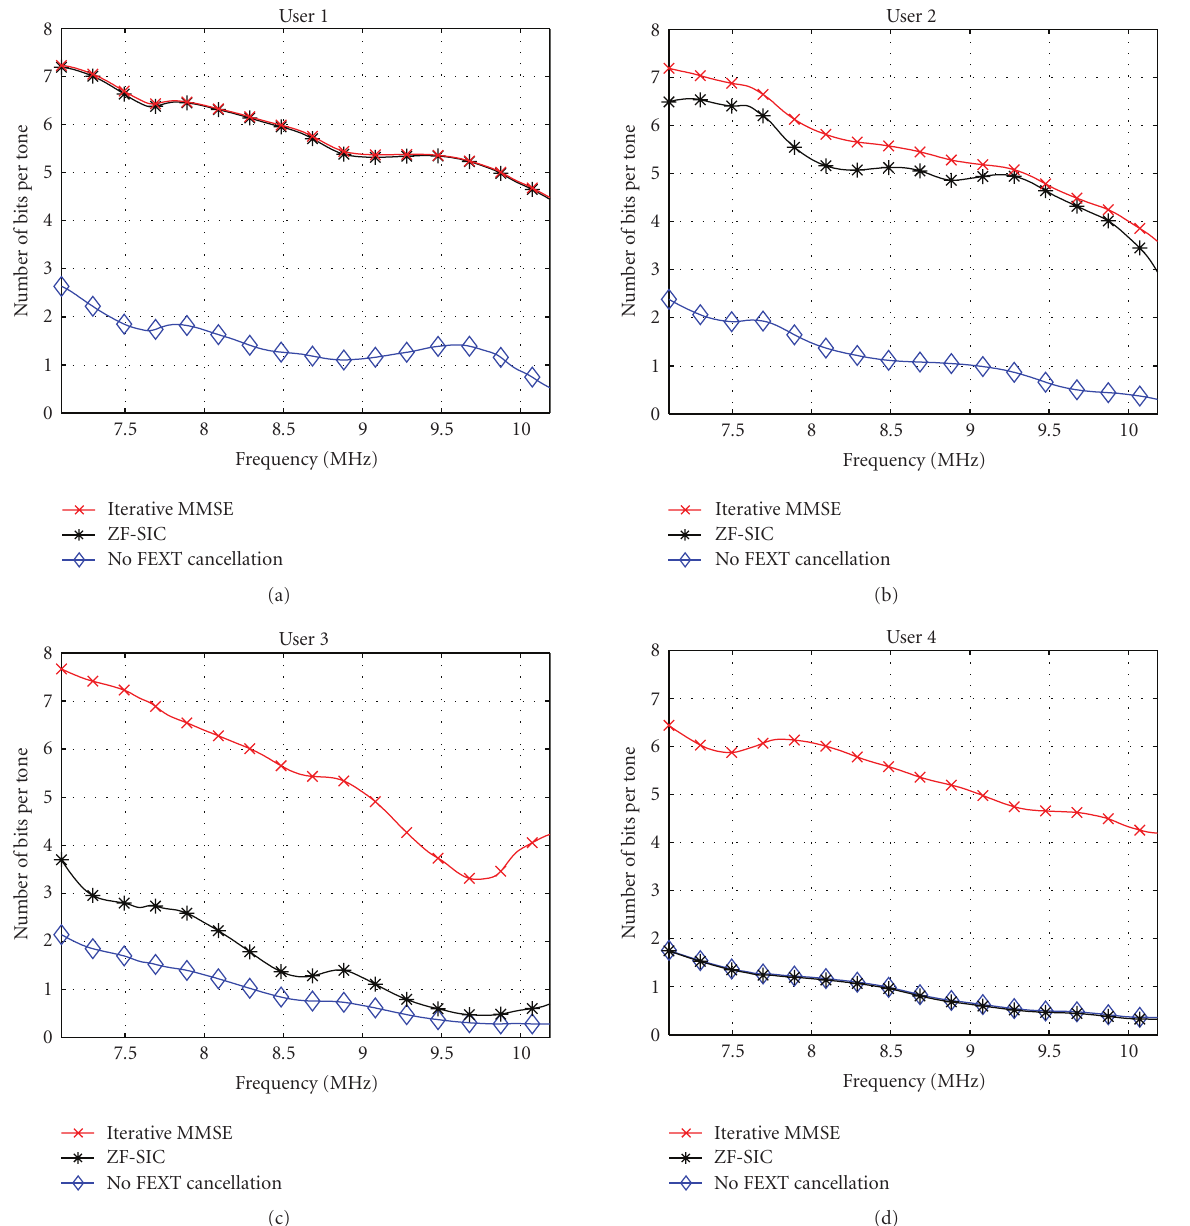
Figure 3: Iterative MMSE and ZF-SIC bit allocation in the coordinated